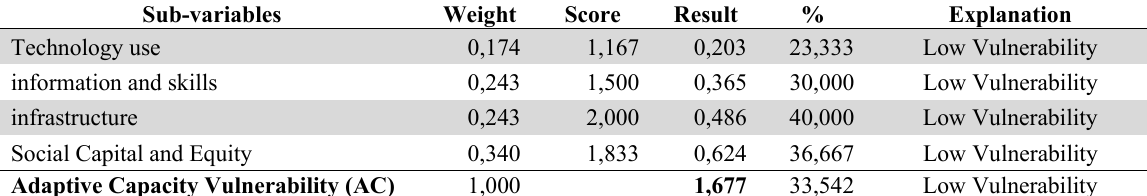
Vulnerability evaluation scores for power relationship of TNI-Polri in Adaptive Capacity variable.